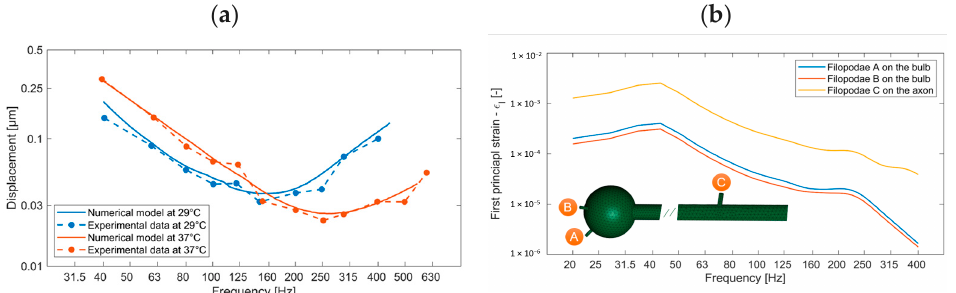
Figure 10. ( a ) Mechano-electrochemical response of Pacinian corpuscles; ( b ) main maximum defor- mations on the three filopodia after coupling the macroscopic and microscopic scales.